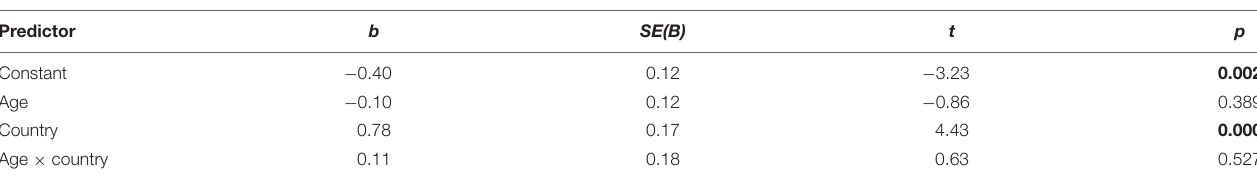
TABLE D2 | Linear model of predictors of multiplication RT.